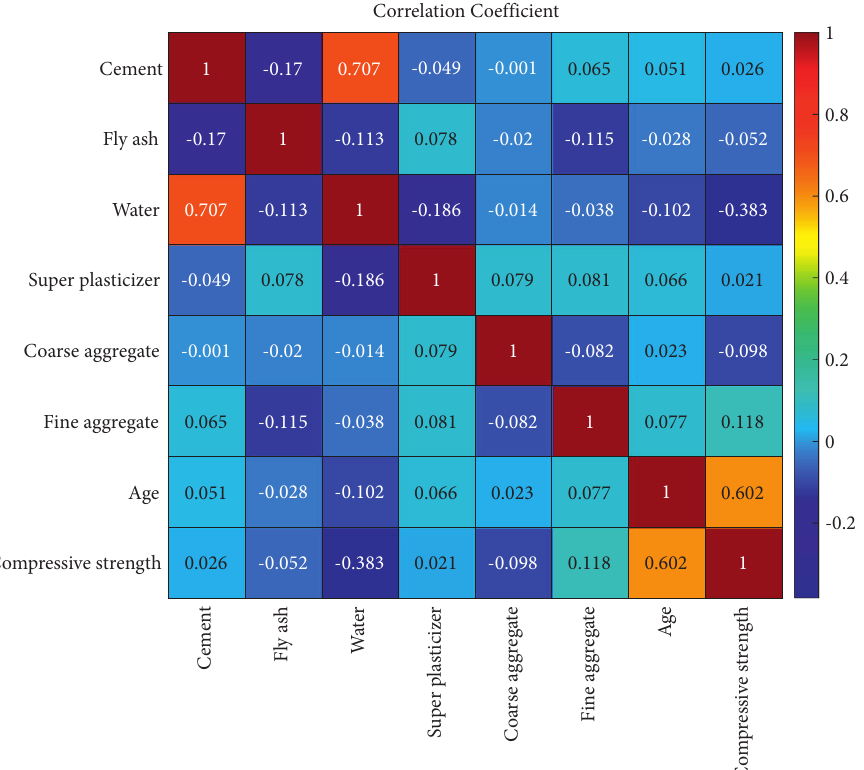
Figure 4: Correlation coefficient of the